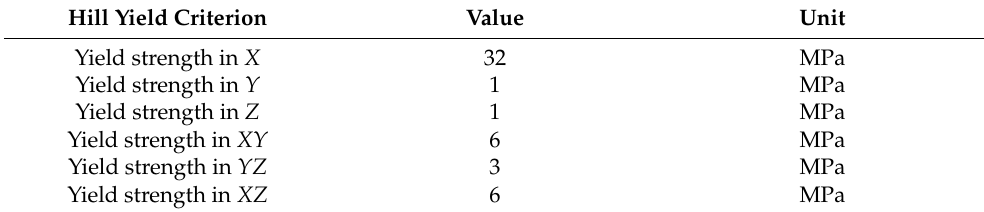
Table 4. Values for the plastic behavior of the material model for timber.